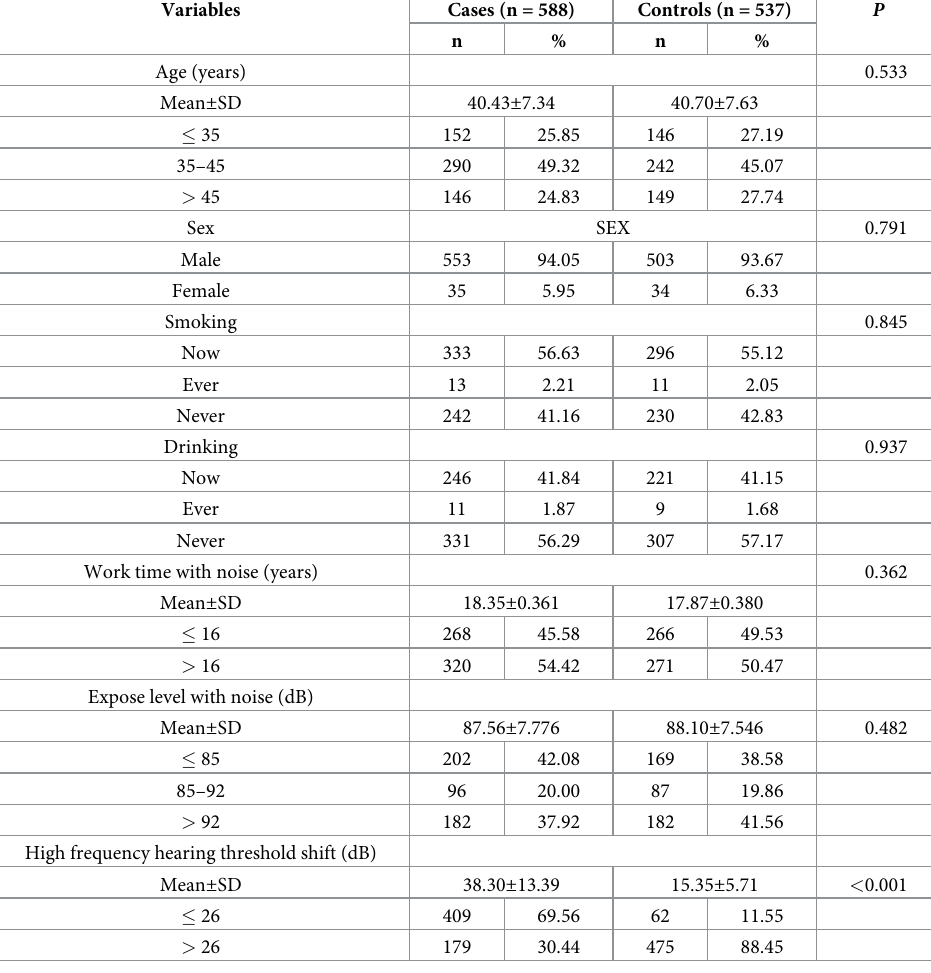
Table 1. Demographic characteristics of study